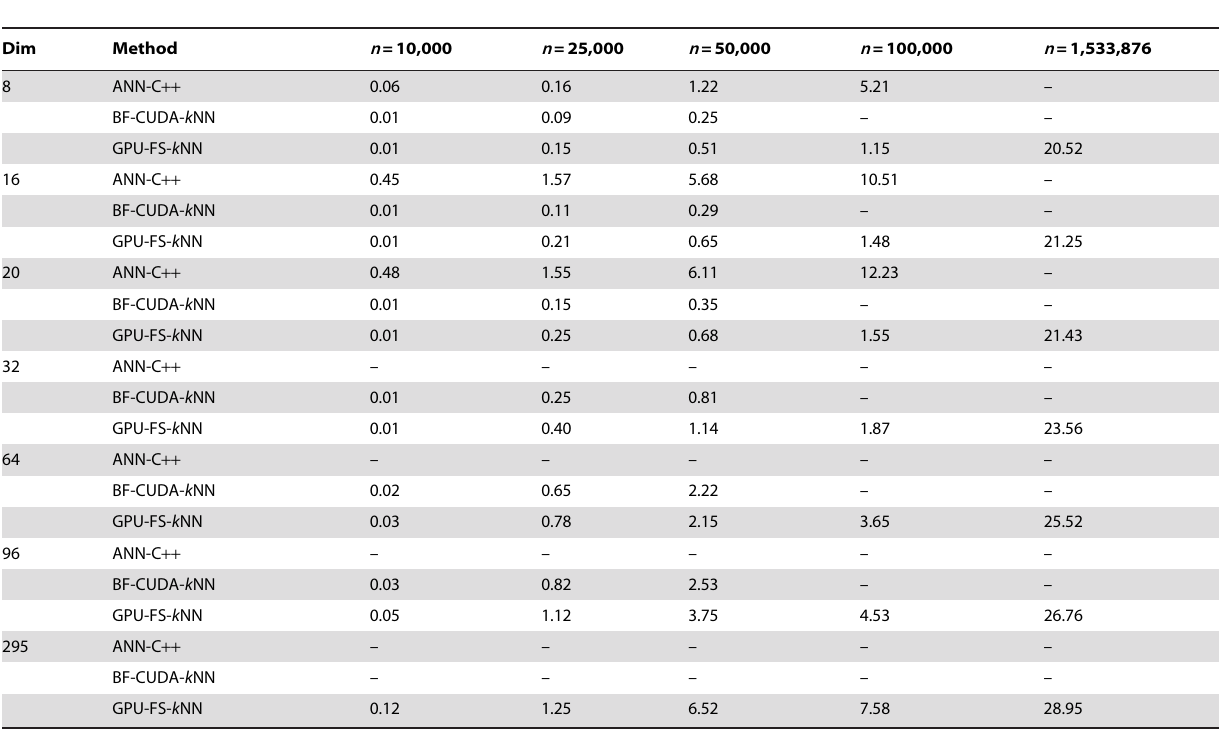
Table 3. Running time comparisons of k NN computation for ANN-C ++ , BF-CUDA- k NN and GPU-FS- k NN on Tesla C2050.